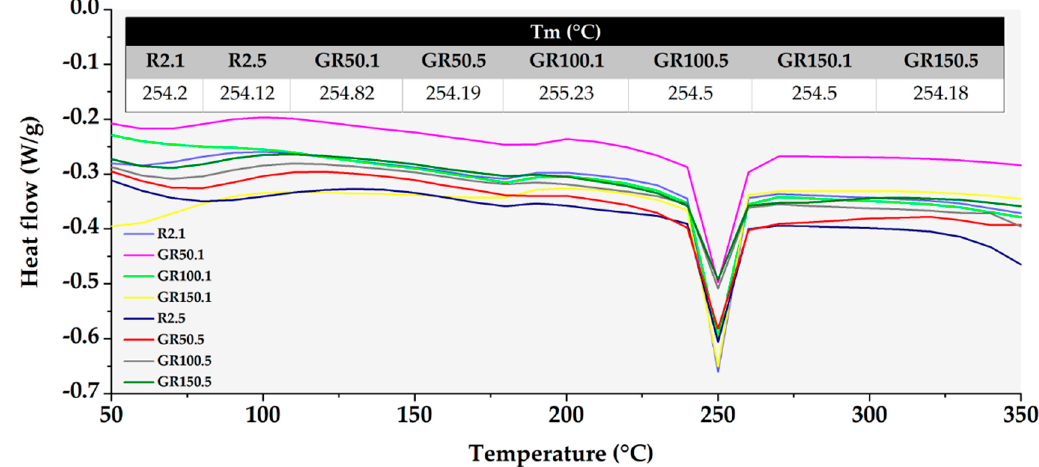
Figure 8. DSC curves of reference and graphene-coated fabrics.